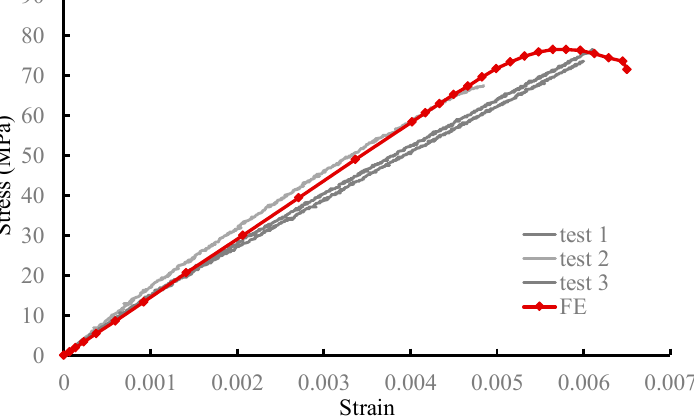
Figure 4. Predicted stress–strain response for the 3D woven SiO 2f /SiO 2 composites under warp tension in comparison with test results.